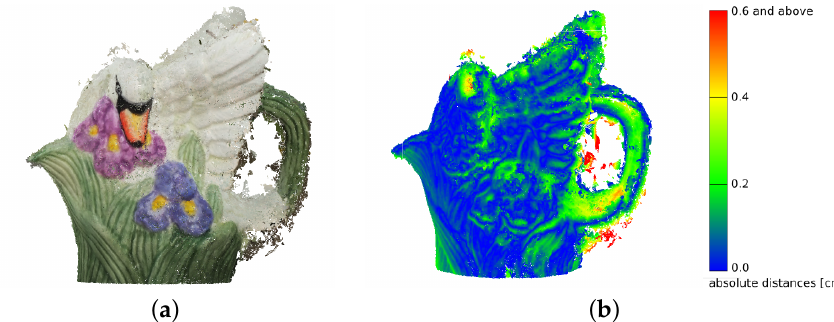
Figure 17. Improved reconstruction of the porcelain figurine: ( a ) RGB dense cloud, ( b ) absolute distance